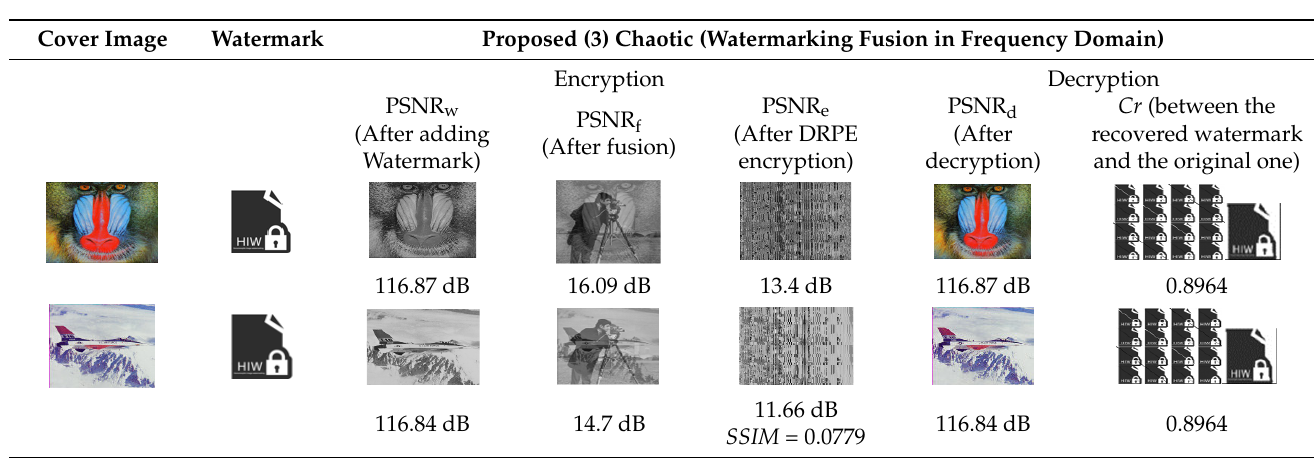
Table 3. Results of the third proposed technique based on